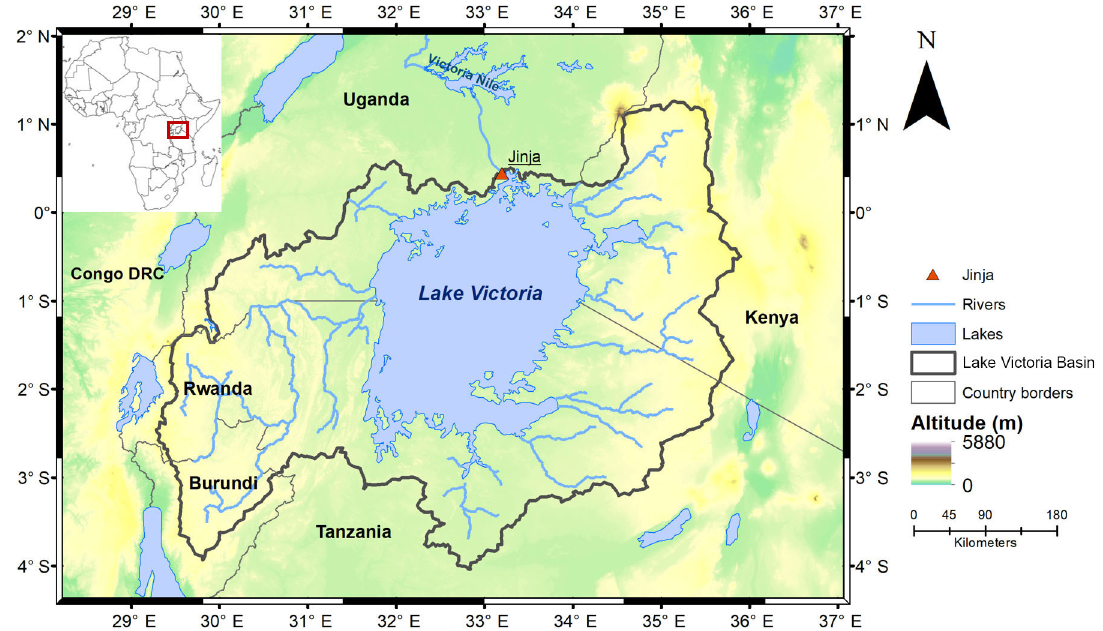
Figure 1. Map of Lake Victoria and its basin with surface heights from the Shuttle Radar Topography Mission (SRTM). Taken from Van- derkelen et al.